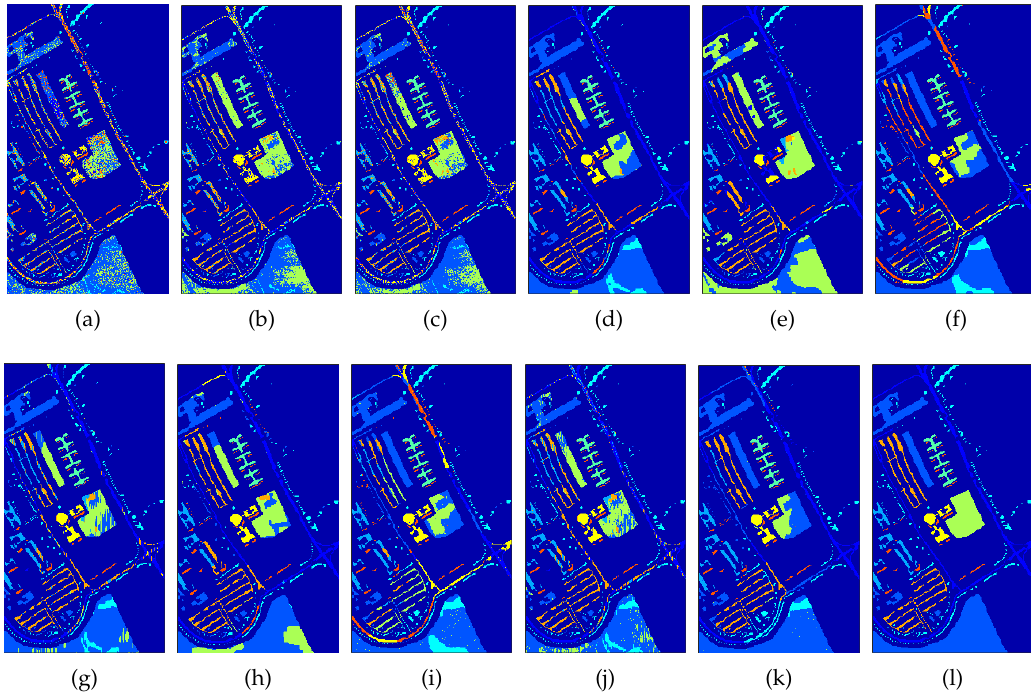
Figure 8. University of Pavia classification maps generated from different methods; ( a ) SunSAL, ( b ) MLR, ( c ) LC, ( d ) MRFG_a , ( e) MRFG, (f) MRF_a, ( g ) MRF_p, ( h ) MRFL, ( i ) CRF_a, ( j ) CRF_p, ( k ) CRFL, ( l ) Ground